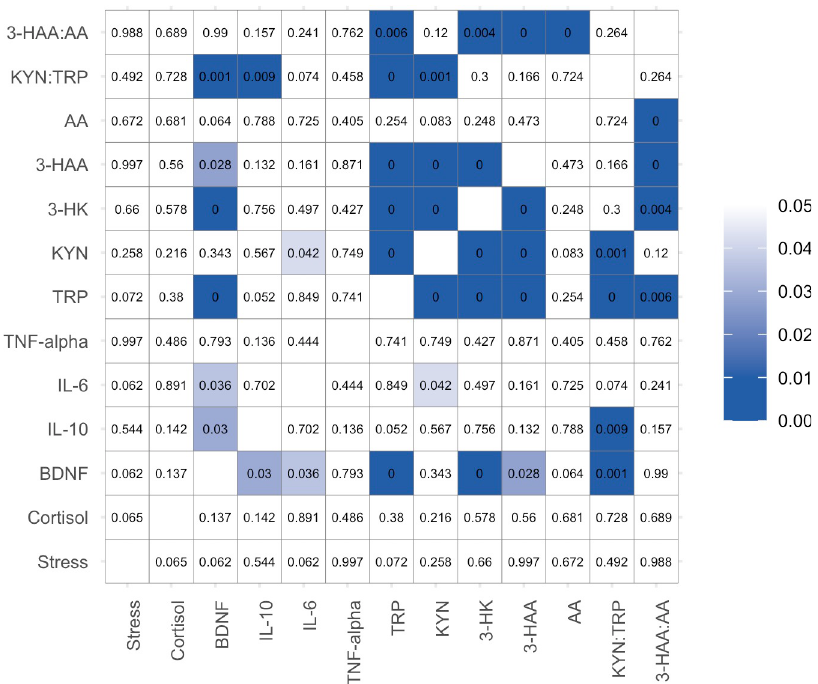
Fig 2. Correlation matrix showing p values between perceived stress scores, the levels of cortisol and BDNF, cytokines, and TRP and KP metabolites during pre-examination period.